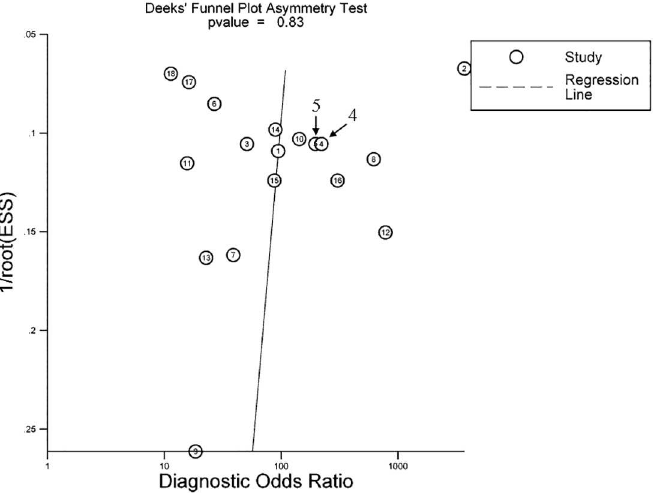
Fig 6. Deeks’ funnel plot to evaluate publication bias. P = 0.83 indicates a symmetrical funnelshape and suggeststhat publicationbias is